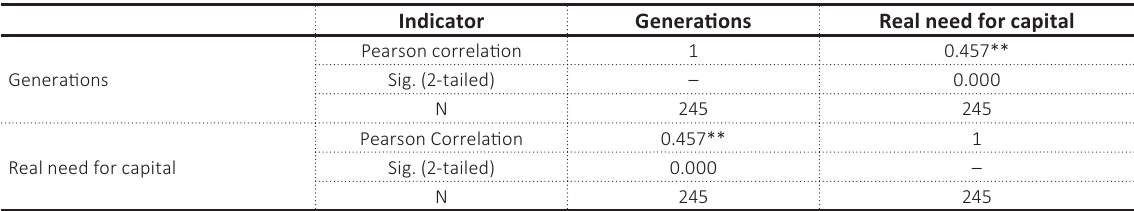
Table 6. Correlation analysis between generations and the need for funds